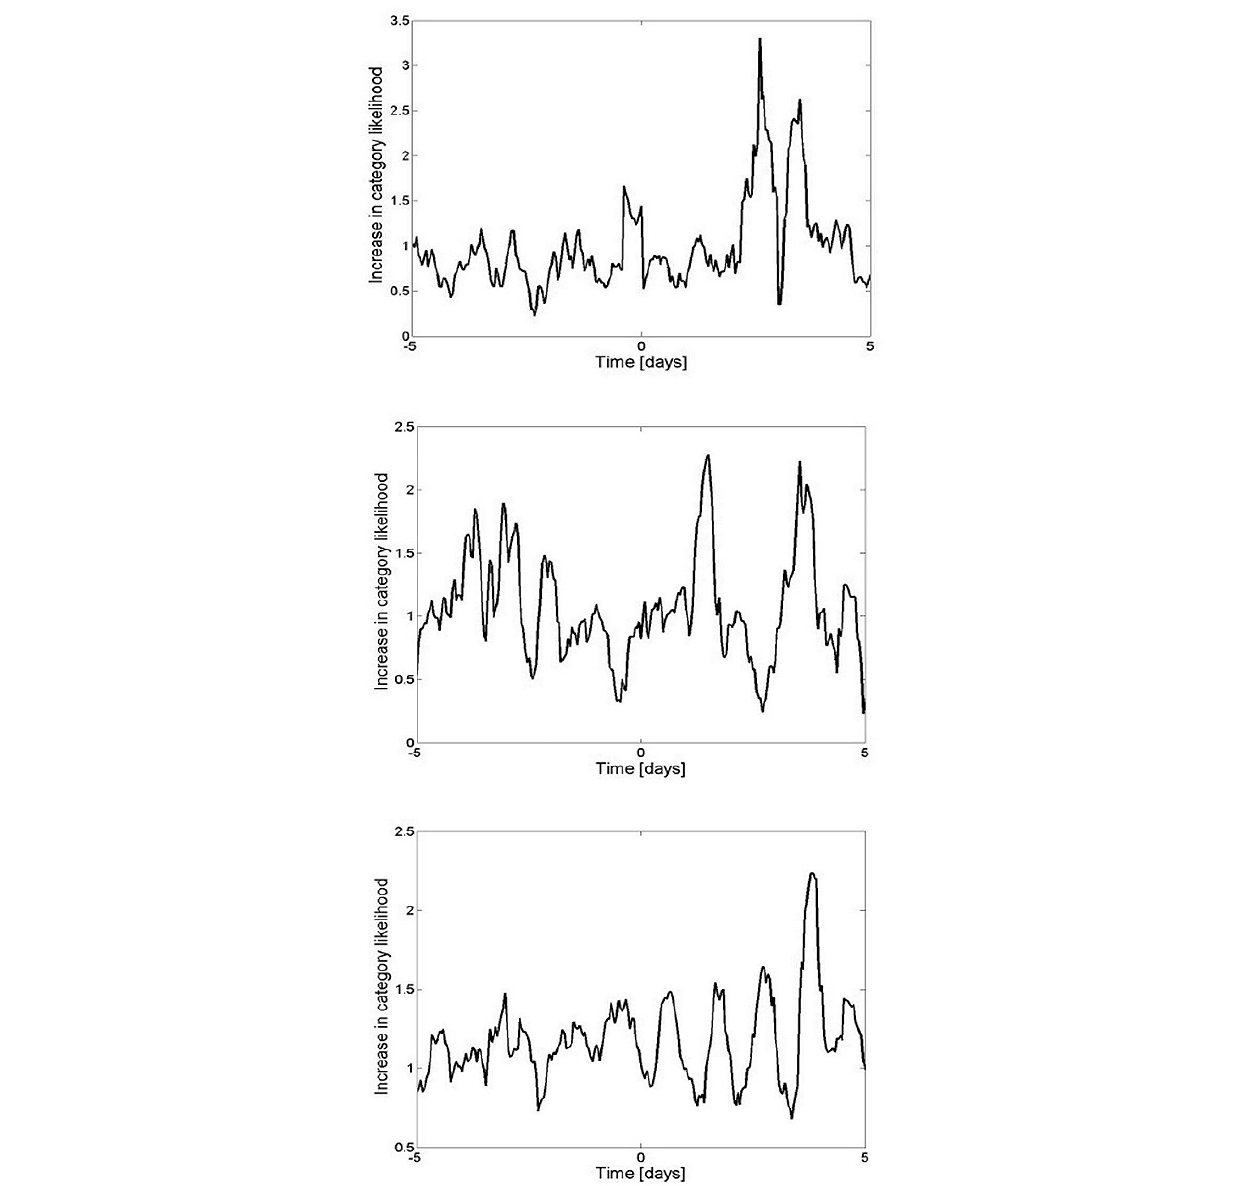
Figure 2. Change in query category likelihood as a function of time. Zero marks time of an MSD query. Categories represented are (from top to bottom): nutrition, business, and adult materials. The time series was smoothed with a moving average 5 hours in